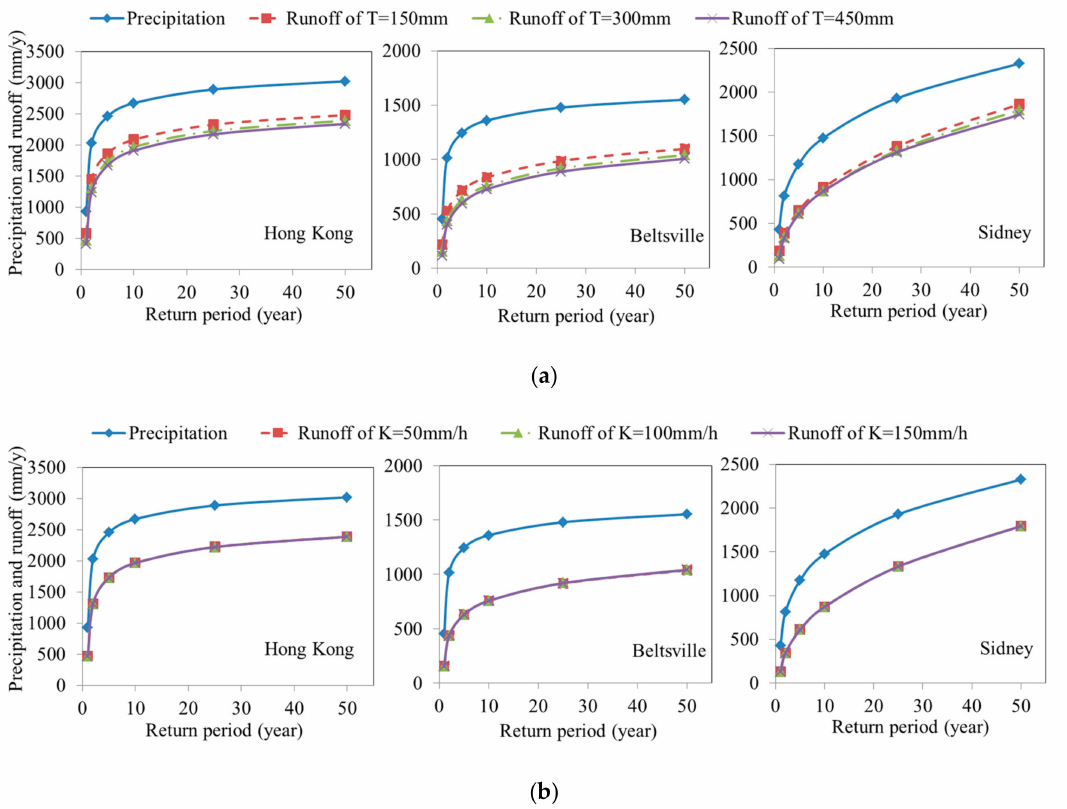
Figure 7. Average runo ff of various green roofs di ff ering in ( a ) soil thickness (T) and ( b ) soil hydraulic conductivity (K). The conductivity in ( a ) is 100 mm / h, and the thickness in ( b ) is 300